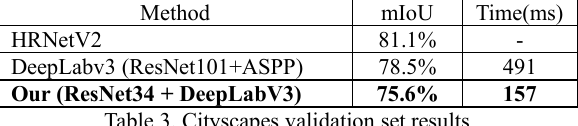
Table 3. Cityscapes validation set results